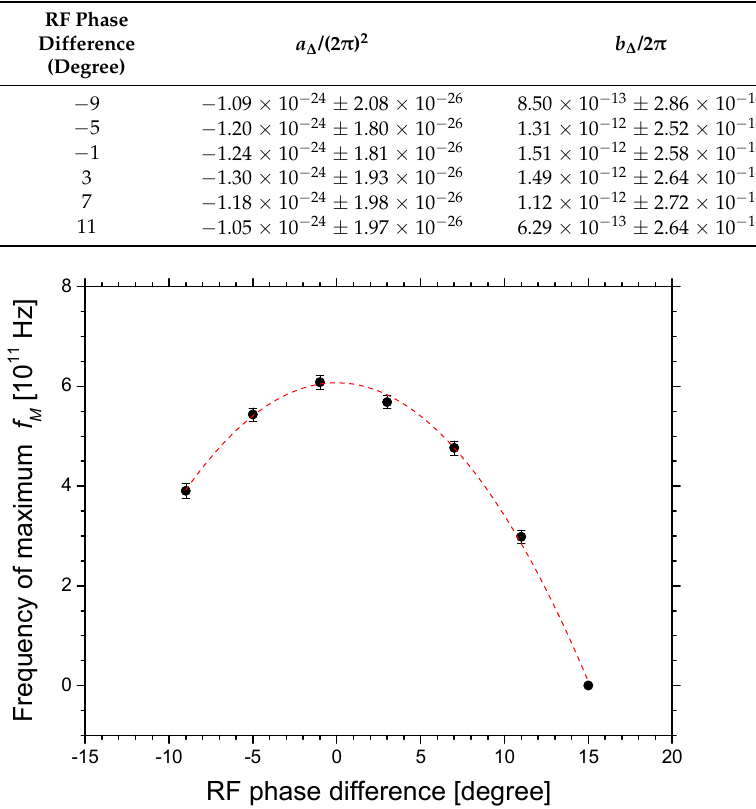
Figure 5. Dependence of f M on RF phase difference ∆. The fitting curve (broken red line) is given by f M = −2.66 × 10 9 ∆ 2 + 6.06 × 10 11 .